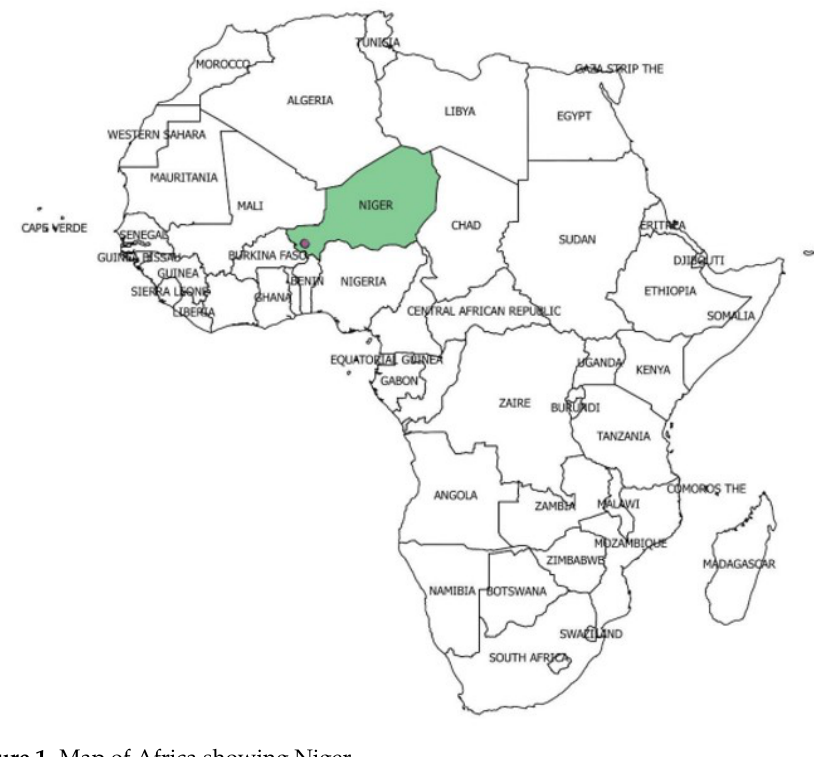
Figure 1. Map of Africa showing Niger.